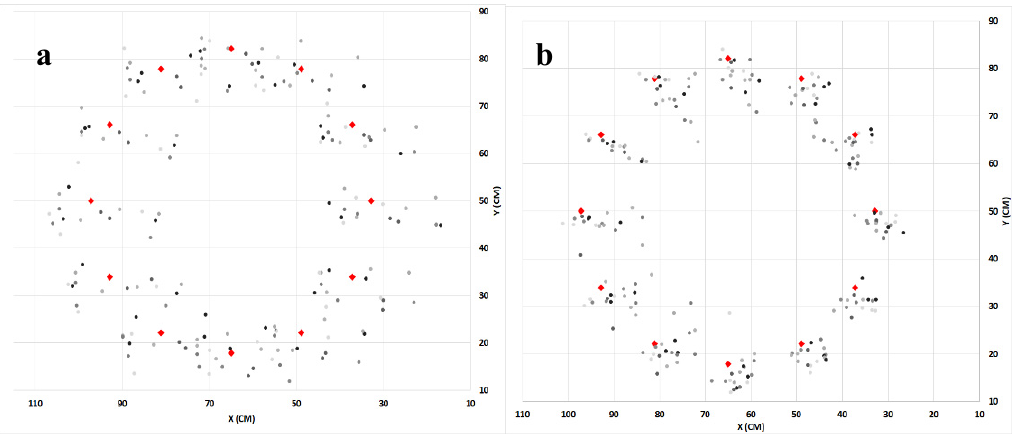
Figure 8. Illustration of all positions judgment from the sixteen participants with respect to the actual (reference) targets at 150 cm distance for ( a ) HMD and ( b ) SWD conditions. It shows that the overall position estimates in the SWD were better than the HMD position estimates.